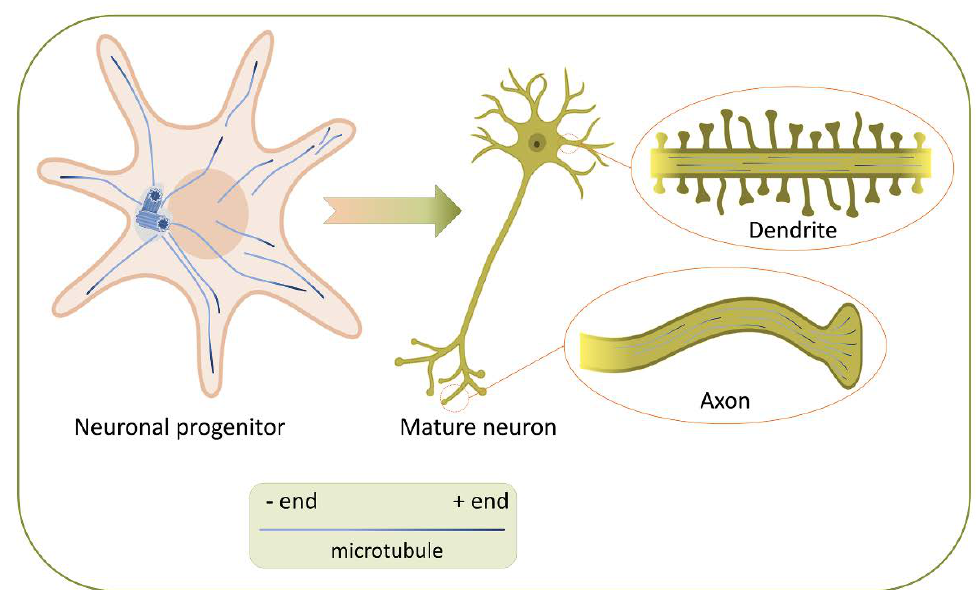
Figure 1. Microtubule organization in neuronal progenitor and mature neuron. In the early stages of neuron polarization, MTs originate from the centrosome, where their minus-ends are located during nucleation and elongation before detachment from the centrosome (or oriented after detachment). Hence, the structure of MTs in neuronal progenitor is radial. When neurites mature into axons and dendrites, the structure of the MT network changes. In dendrites, MTs became antiparallel: unique feature of the dendritic MT cytoskeleton is the appearance of MTs with their minus-ends oriented towards the dendritic tips. Simultaneously, in the axons, all the minus-ends are directed towards the body of the neuron.